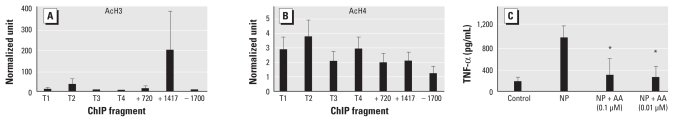
Involvement of histone acetylation in the regulatory effect of NP on TNF-α expression. ChIP analyses of the relative levels of acetylated H3 (AcH3; A) and acetylated H4 (AcH4; B) at the TNFA gene locus encompassing the following subregions relative to the transcription start site: TNF1 (T1; +99 to −42); TNF2 (T2; +32 to −119), TNF3 (T3; −100 to −250), TNF4 (T4; −195 to −345), +1417, +720, and −1700. The relative levels were normalized to the input DNAs and are shown as mean ± SD of five study subjects. (C) TNF-α expression levels in 10−8-M NP–treated mDCs in the presence or absence of varying doses of a histone acetyltransferase inhibitor, anacardic acid (AA).*p < 0.05 compared with NP treatment alone.